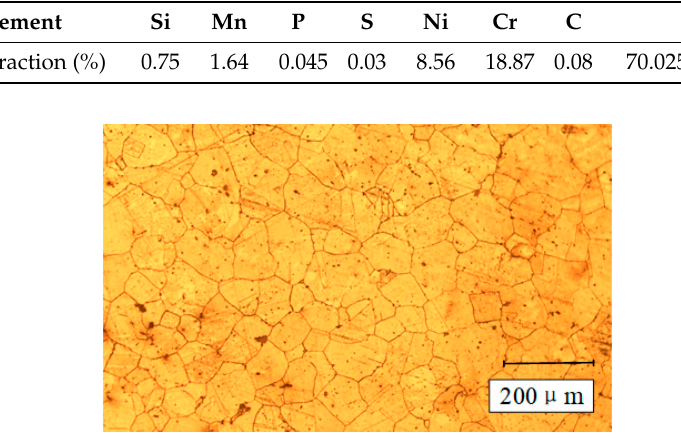
Table 1. Composition of workpiece material.